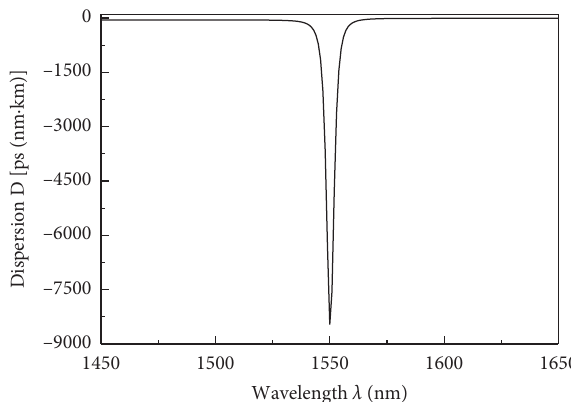
Figure 9: Variation of the dispersion with